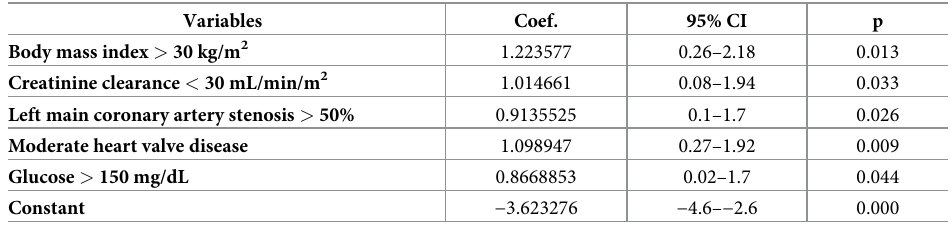
Table 3. Elaboration of HiriSCORE model.